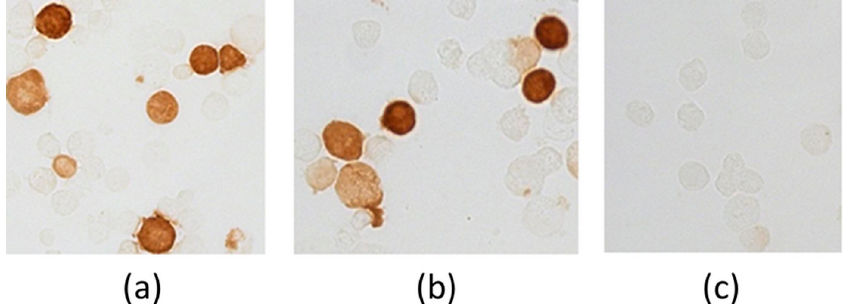
Figure 3. Evidence of genes expression in cells transfected with plasmids pEV.CTL and pEV.Th by immunohistochemical staining. ( a ) 293T-cells transfected with p EV.CTL plasmid. ( b ) 293T-cells transfected with p EV.Th plasmid. ( c ) 293T-cells transfected with pcDNA3.1 vector plasmid.